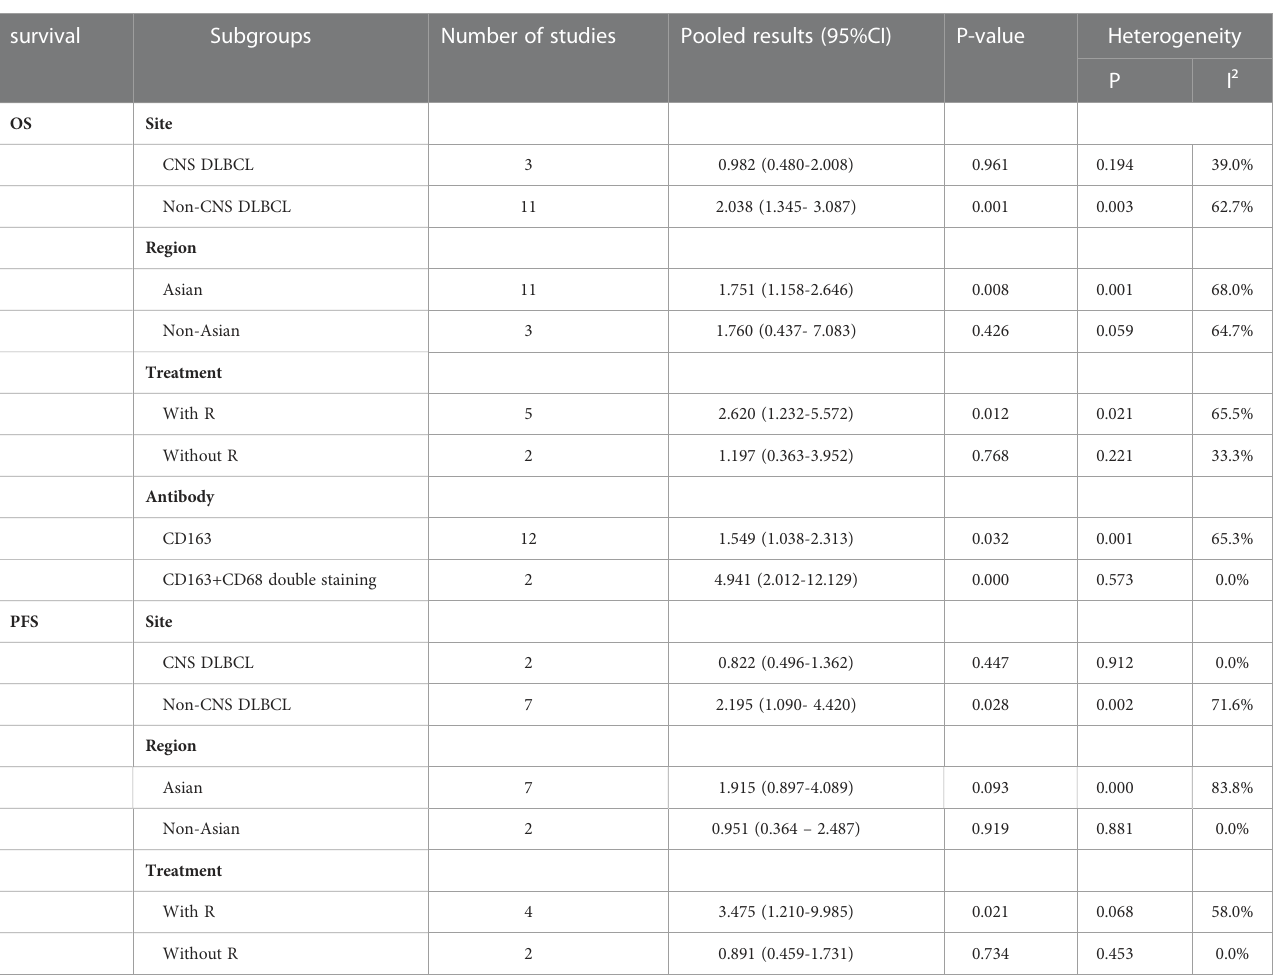
TABLE 3 Subgroup analysis of M2 TAMs and survival.